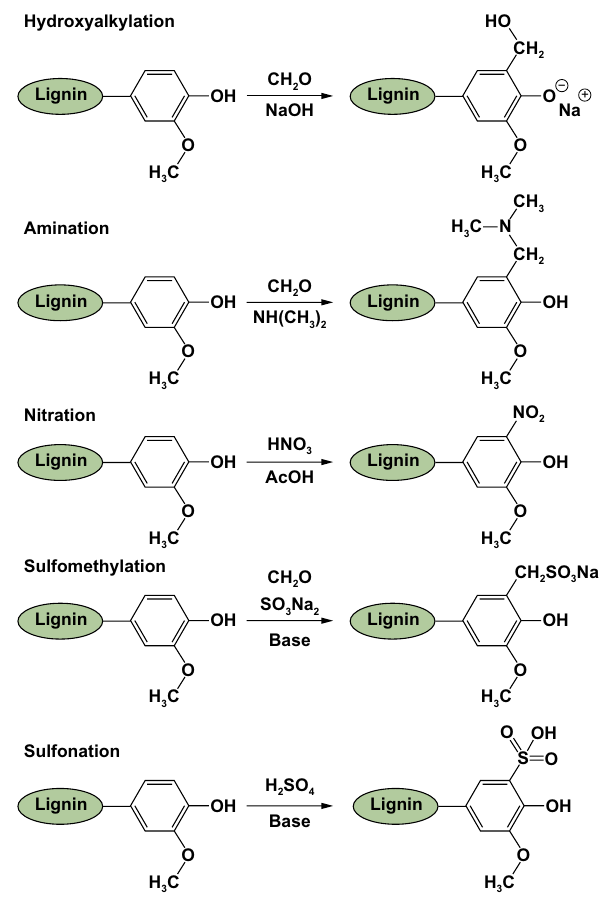
Fig. 6 Overview of the chemical modifications of lignin: synthesis of new chemically active sites